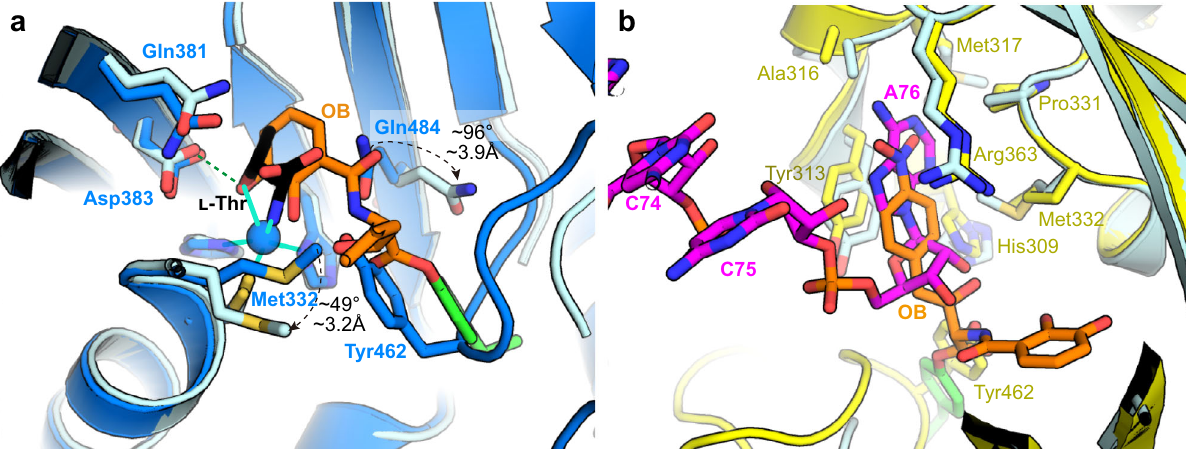
Fig. 3 OB precludes ThrRS binding of L -threonine and tRNA. a Superimposition of the ThrRS- L -Thr structure (blue cartoons, PDB code: 1EVK) with the ThrRS- OB structure (light cyan cartoons). OB is shown as orange sticks. L -Thr is shown as black sticks. H-bonds are shown as green dashed lines. Coordination bonds are shown as cyan lines. b Superimposition of the ThrRS-tRNA Thr structure (yellow cartoons, PDB code: 1QF6) with the ThrRS-OB structure (light cyan cartoons). The nitrophenyl group forms stacking interactions with Tyr313 and Arg363, which also interact with tRNA A76 in a similar